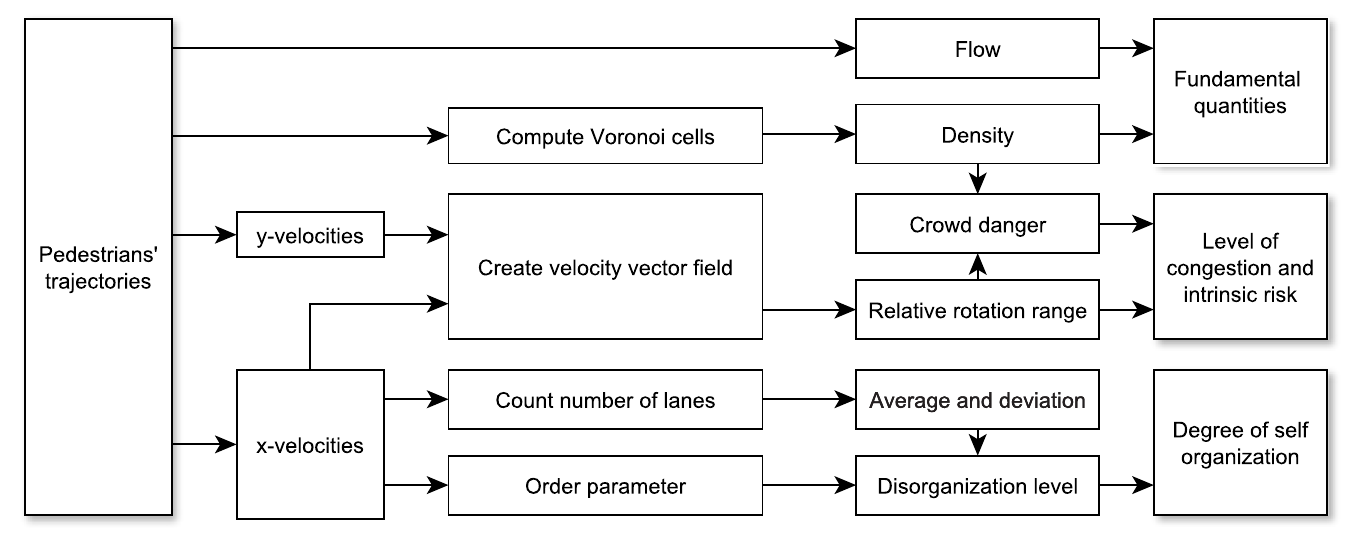
Fig 5. Computational method and relevant quantities. Summary of the quantities considered in this study and methods used to compute them.